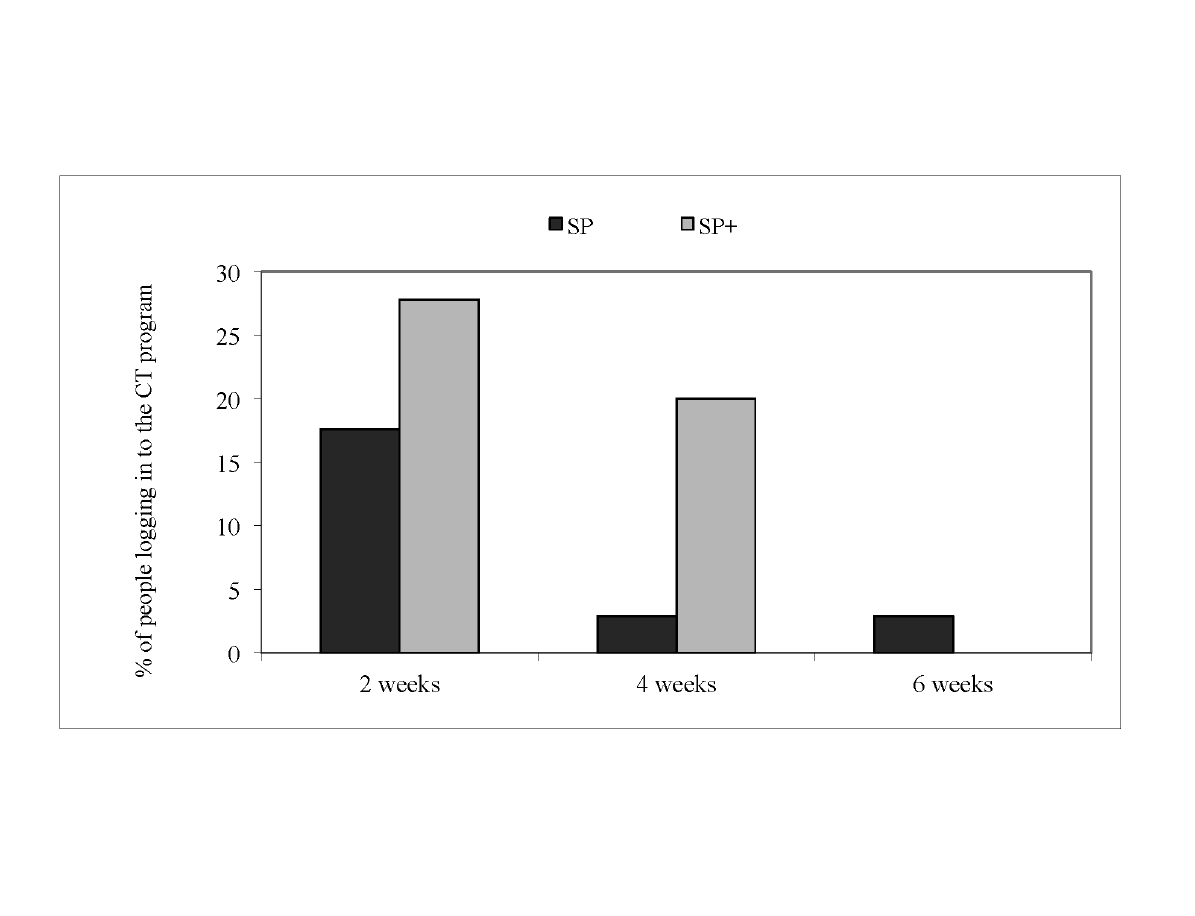
Figure 2. Percentage of participants given standard prompts (SP) and standard+ prompts (SP+) who logged in to the program at different levels of prompt